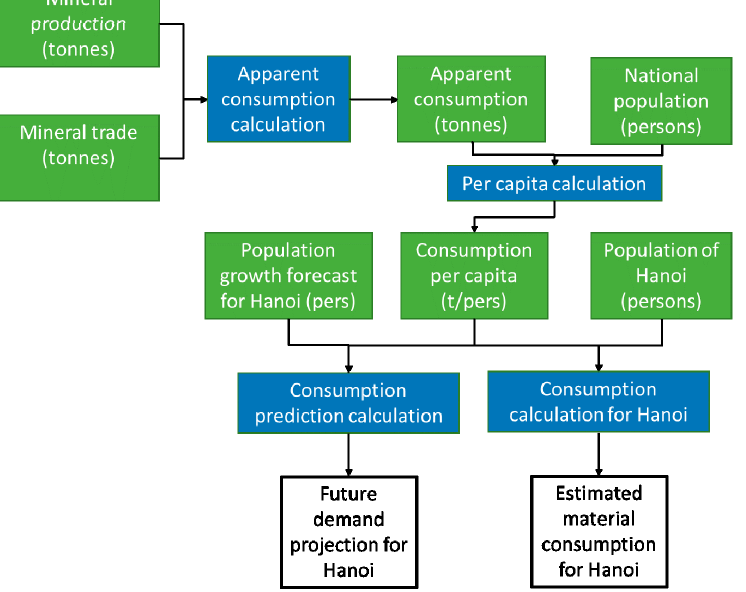
Figure 2. Schematic diagram explaining the steps involved in the top-down future supply and demand balance calculation.